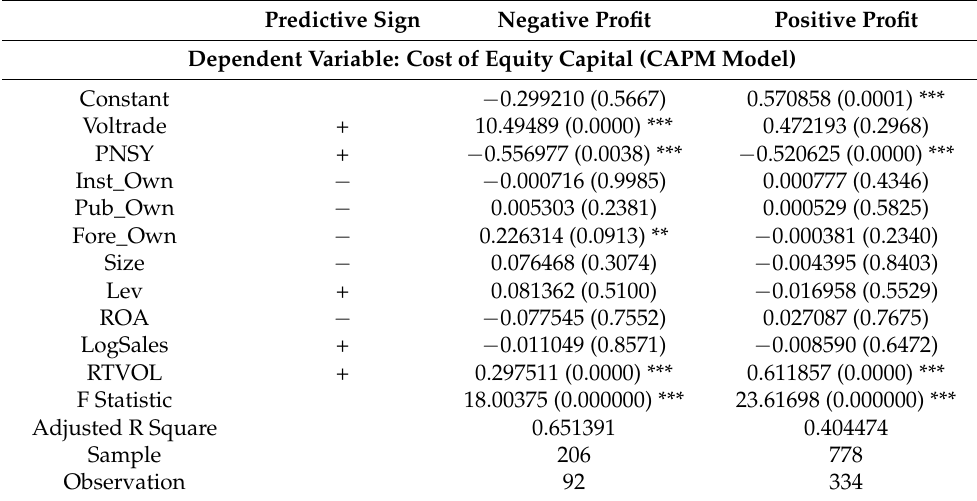
Table 7. Additional tests based on the level of